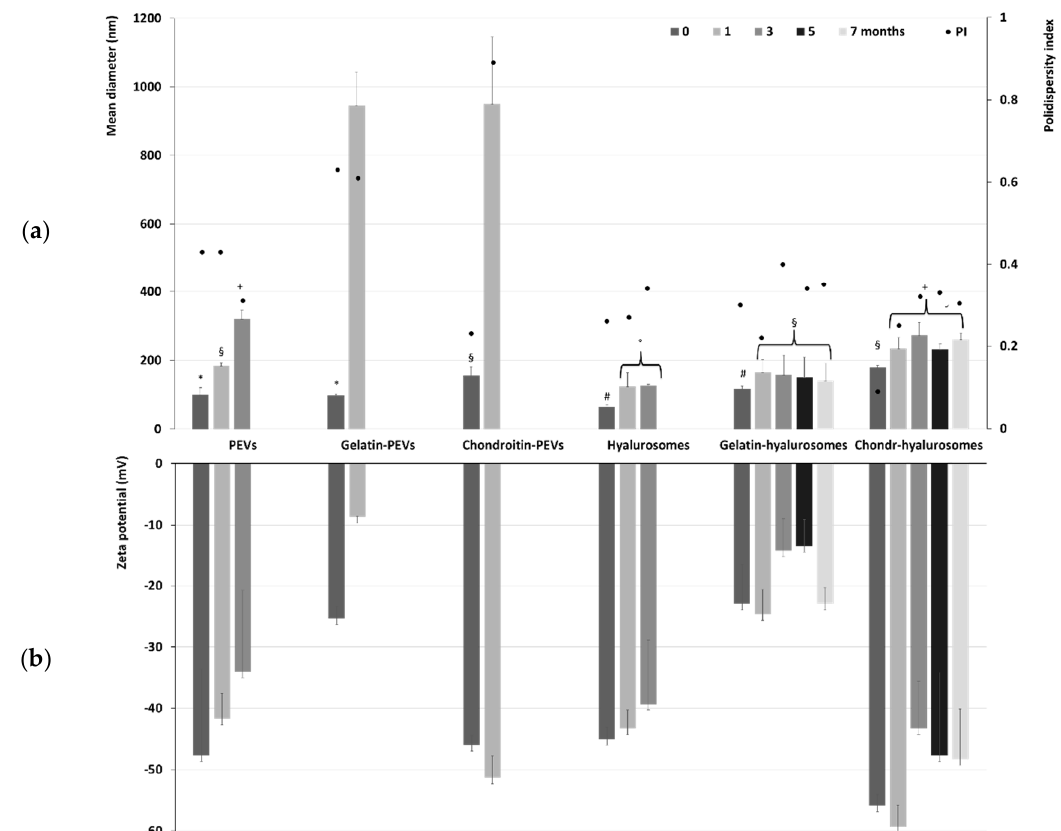
Figure 2. ( a ) Mean diameter, polydispersity index (PI) and ( b ) zeta potential of the extract-loaded PEVs, gelatin-PEVs, chondroitin-PEVs, hyalurosomes, gelatin-hyalurosomes, chondroitin-hyalurosomes, measured over seven months. Data represent the means ± standard deviations of at least six replicates. The same symbol (*, § , + , # , °) indicates the same value.